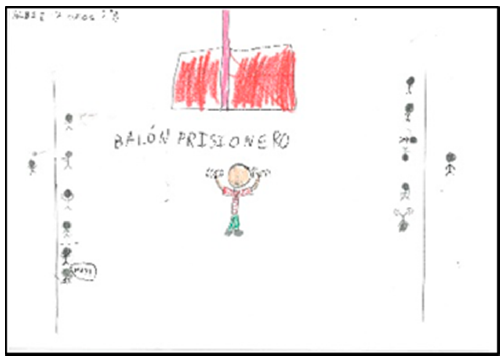
Figure 2. Larger teacher. Sergio. 2°A.